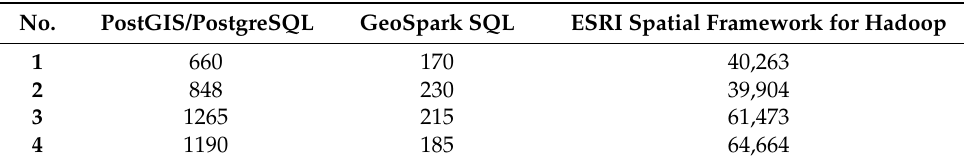
Table 5. Performance of attribute queries (in milliseconds).